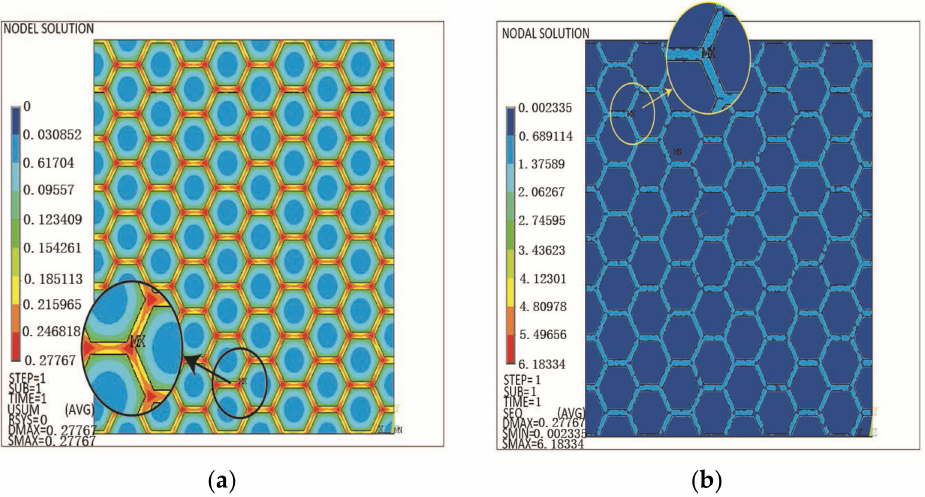
Figure 6. ( a ) Deformation nephogram of the cell structure. ( b ) Von Mises stress nephogram of the cell